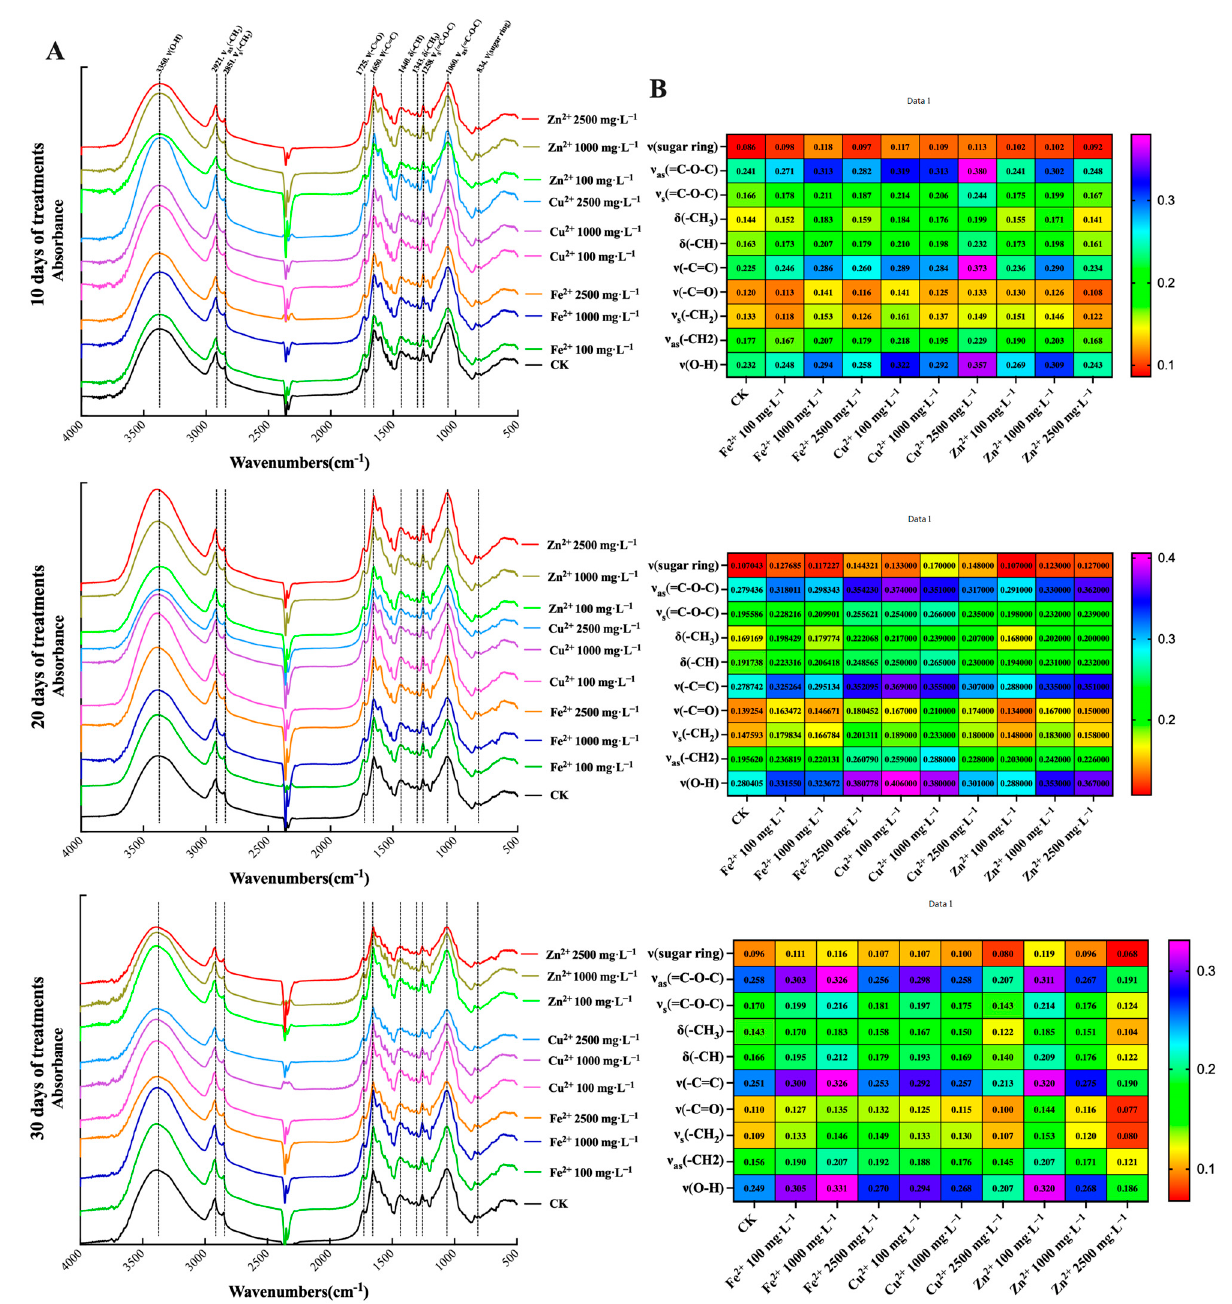
Figure 3. The characteristic absorption peaks of FT-IR spectra between 4000 and 500 cm − 1 in E. sagittatum leaves after spraying with mineral elements (10 days, 20 days, and 30 days). The data are expressed as the means ± SDs (standard deviations, n = 5). ( A ) The FT-IR spectra between 4000 and 500 cm − 1 in E. sagittatum leaves after 10 days, 20 days, and 30 days of treatment. ( B ) Heatmap of the changes of characteristic absorption peaks in E. sagittatum leaves after 10 days, 20 days, and 30 days of treatment.